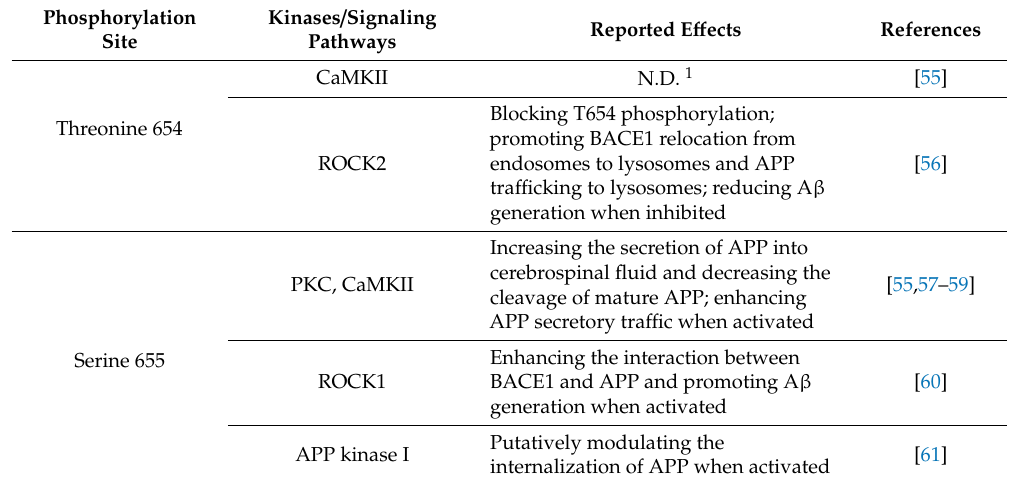
Table 1. Reported phosphorylation sites of APP695 and its e ff